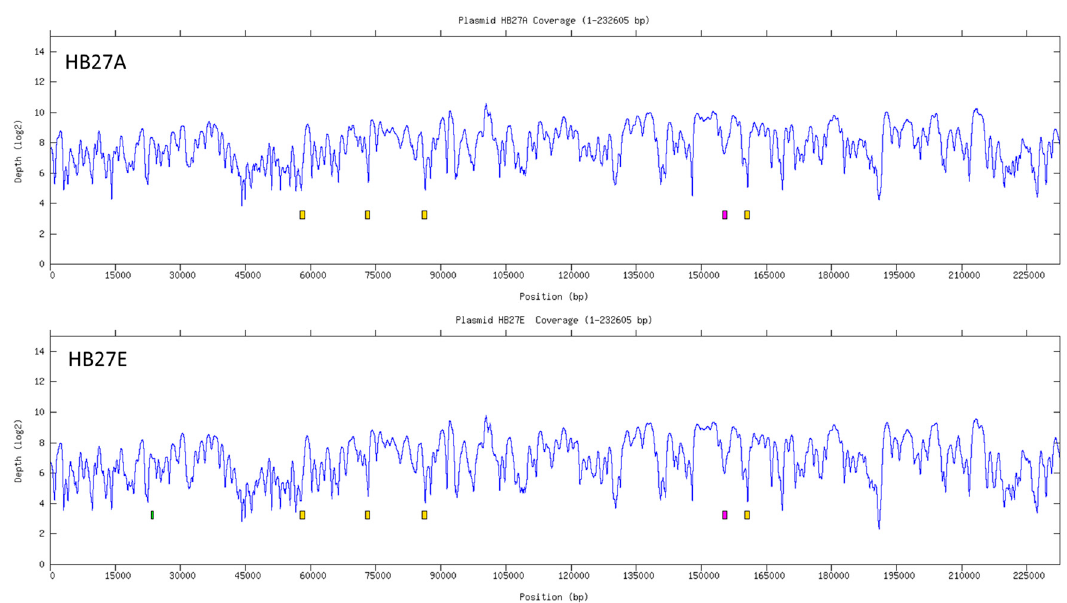
Figure 4. Identification of recent events of transposition by ISTth7 in the megaplasmid of T. thermophilus HB27. Coverage plot of HB27A (upper), HB27E (lower) reads plotted against the T. thermophilus HB27 reference pTT27 plasmid. Yellow boxes show the location of the ISTth7 transposase common between the reference HB27 genome and to the laboratory-adapted strains HB27A and HB27E. The pink box labels the position of an ISTth7 copy common to both HB27A and HB27E which is absent from the reference HB27, while the green box indicates the location of an ISTth7 copy specific to the HB27E strain.